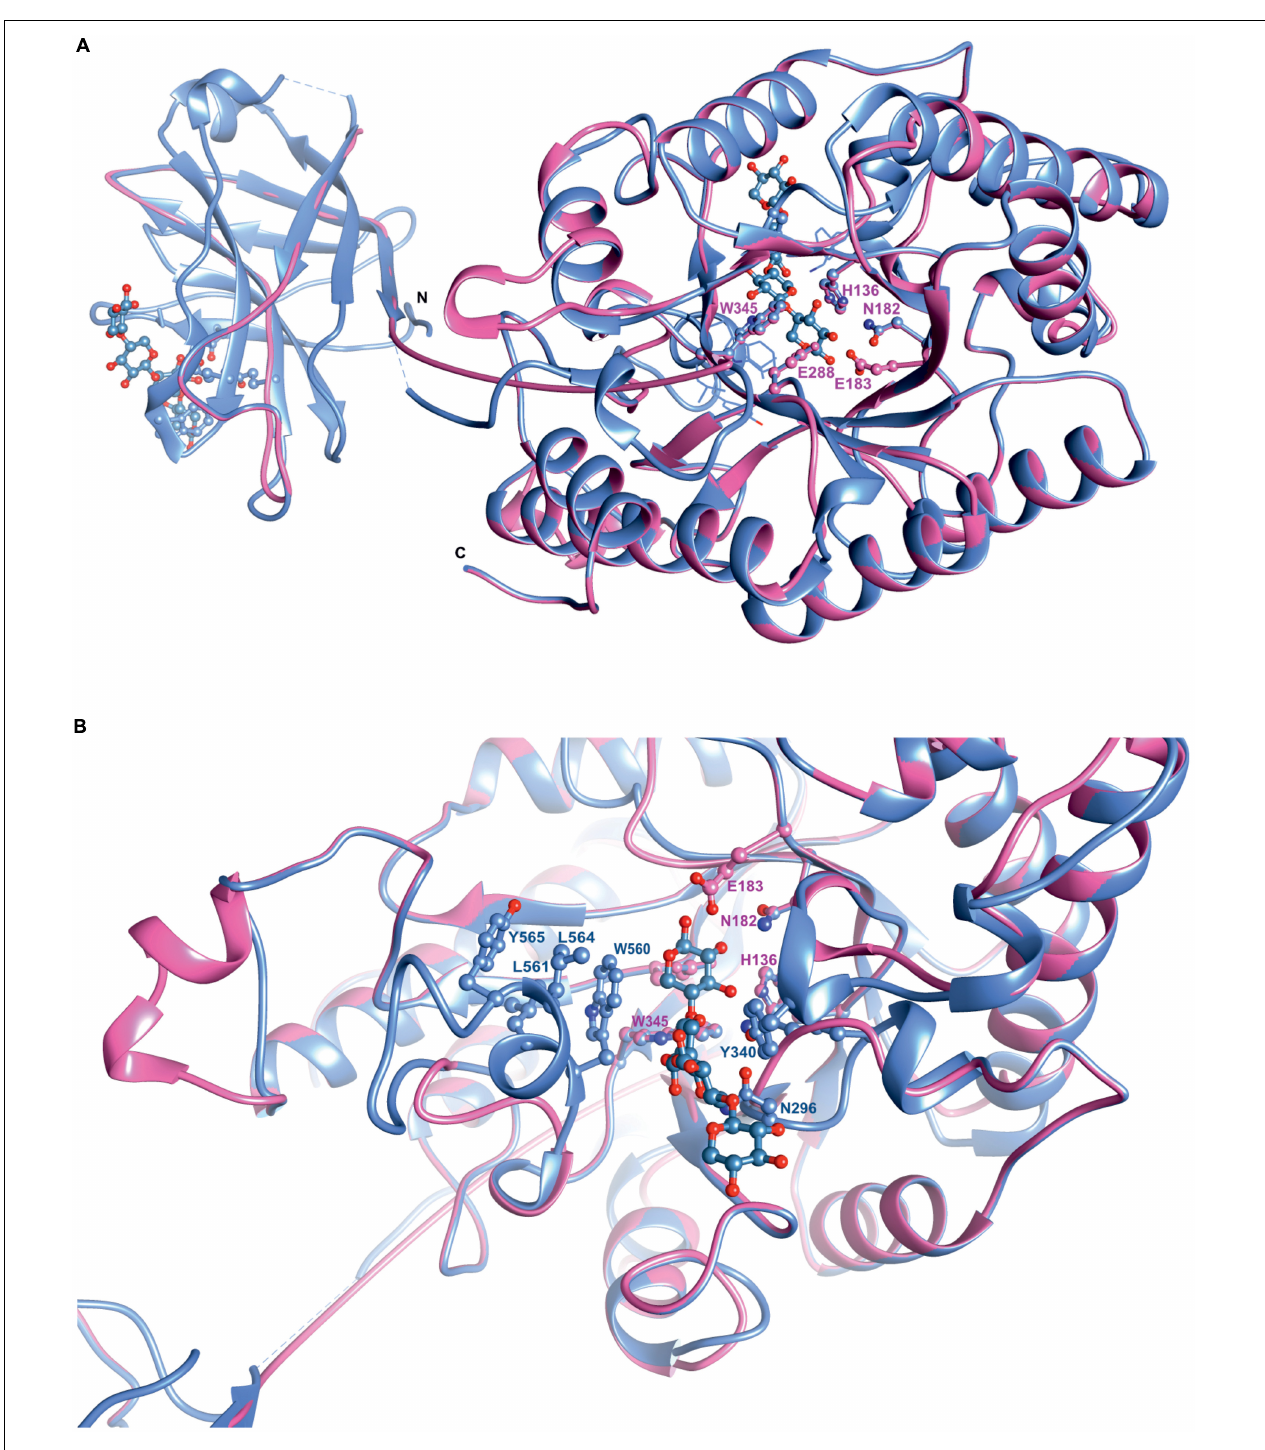
FIGURE 8 | Superposition of the XynDZ5 modeled structure with its closest structural homolog. The modeled 3D structure of XynDZ5 shown in pink is superimposed on the 3D structure of its closest structural homolog Cj Xyn10C-m [PDB ID 1us2, Pell et al. (2004)] shown in cornflower blue using their corresponding secondary structural elements. In ball-and-stick representation are the conserved amino acids of the catalytic site and xylopentaose that binds to xylanase10C is shown in blue. N and C are the N- and C- termini, respectively, (A) . Top view showing the entrance of the catalytic site, highlighting the differences in the loop regions between XynDZ5 modeled structure and the structure from C. japonicus . Residues W560, L561, L564, and Y565 from Cj Xyn10C-m form a loop region closer to the catalytic site along with residues N296 and Y340 that stabilize the interactions with the ligand. These residues are not present in the model of XynDZ5 and the loops are in a different orientation, resulting in a more “open” site (B) . The figure was prepared using UCSF Chimera (Pettersen et al., 2004).